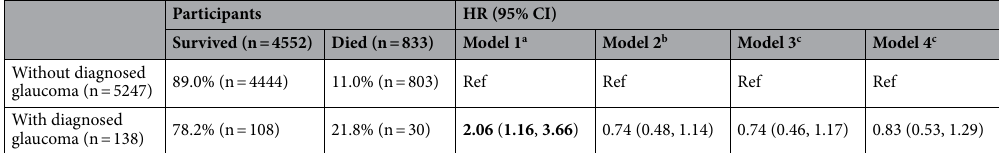
Table 3. Associations between diagnosed glaucoma and overall mortality from Cox Proportional Hazards Models. Participant frequencies are survey-weighted, counts are unweighted. Mortality risk among individuals with glaucoma was statistically signficantly higher at a p-value of 0.02 in Model 1 (HR in bold), but not in any of the other models (all p-values > 0.05). a Unadjusted. b Adjusted for age. c Adjusted for age and sex. d Adjusted for age, sex, ethnicity, marital status, health insurance status, education level, alcohol consumption, smoking status, physical activity, BMI, use of glaucoma treatment, comorbid eyes diseases (age-related macular degeneration, retinopathy, history of cataract surgery), prevalent diabetes, history of cancer, history of CVD.